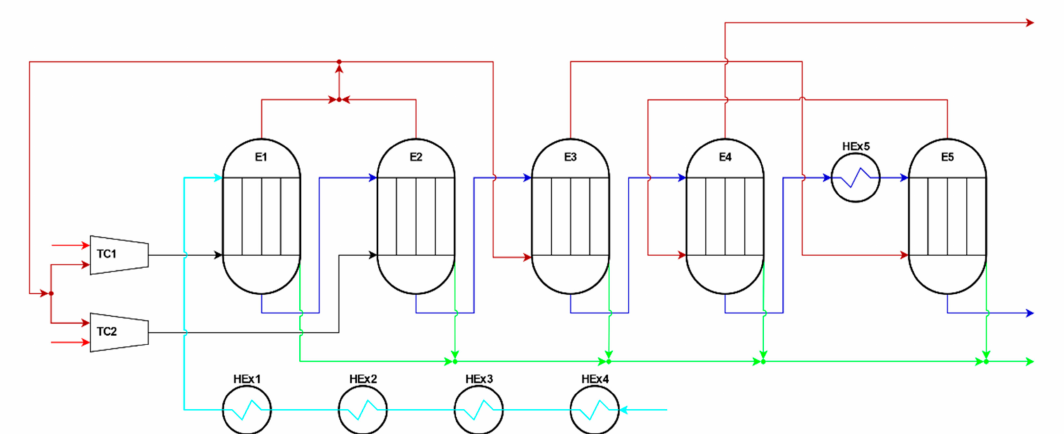
Figure 1. Simplified process flowsheet of milk preheating and concentration section of the milk drying unit (light blue—fresh whole milk, dark blue—concentrated milk, light red—live steam from boiler room, dark red—steam generated by milk solution evaporation, black—thermocompressor discharge steam, green—steam condensate after expansion). TC—thermocompressor, E—evaporator e ff ect, HEx—heat